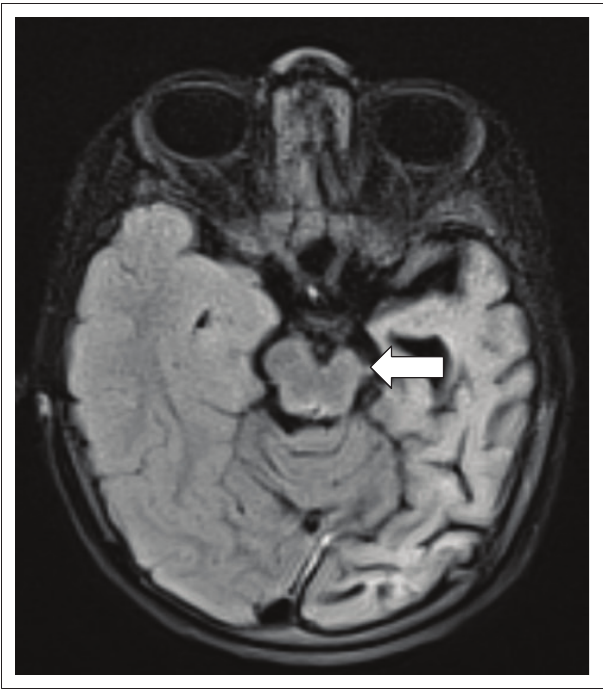
FIGURE 2: Axial fluid attenuation inversion recovery sequence showing small sized left cerebral peduncle because of Wallerian degeneration (arrow) with left cerebral